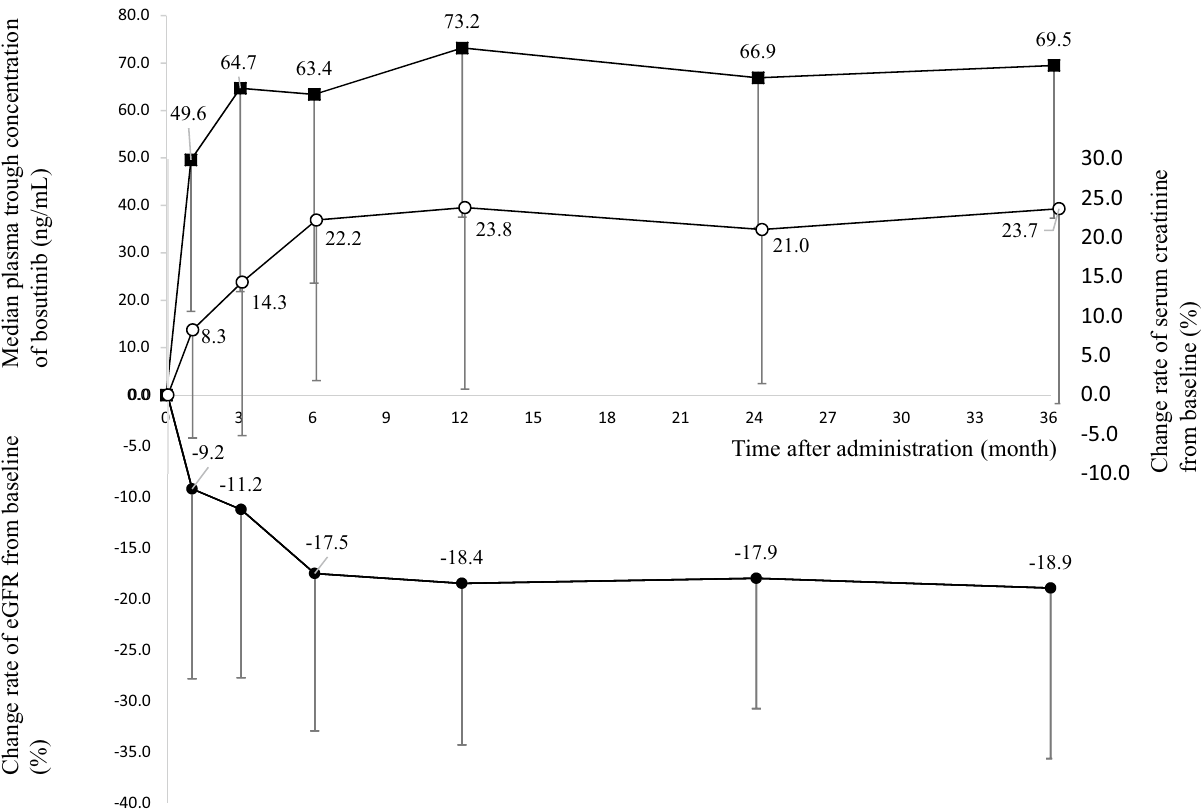
Figure 2. Time course of median plasma trough concentrations of bosutinib (closed squares) and change rates from baseline of serum creatinine (opened circles) and eGFR (closed circles) after bosutinib administration.